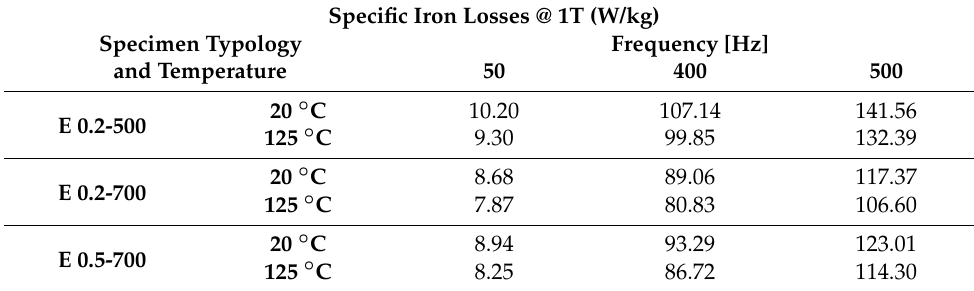
Table 2. Specific iron losses for different frequencies.